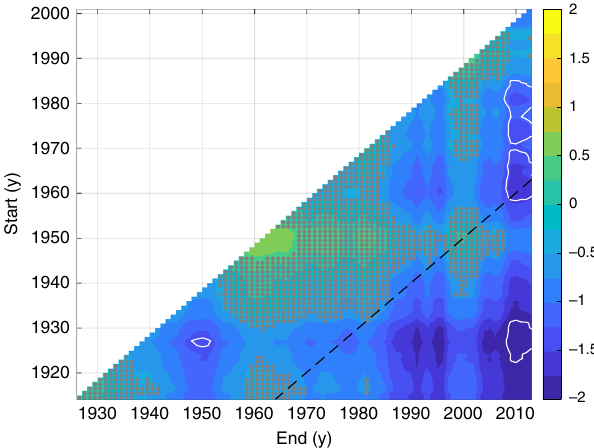
values Fig. 3 Weakening of Florida Current transport over different periods. Shading shows posterior median estimates of the change in decadal- average Florida Current transport between all pairs of decades (Sv). Negative values indicate that transport fell between the start and the end of the period. Stippling indicates that it is as likely as not (0.33 < P < 0.67) that transport rose or fell. White (black) contours encircle periods when it is very likely ( P > 0.90) that transport weakened (strengthened) from the start to the end decade more than expected from a stationary red-noise process; see “ Methods ” section for discussion of signi fi cance calculations. Black dashes mark >50-y periods (values below and to the right of the line correspond to periods with duration >50